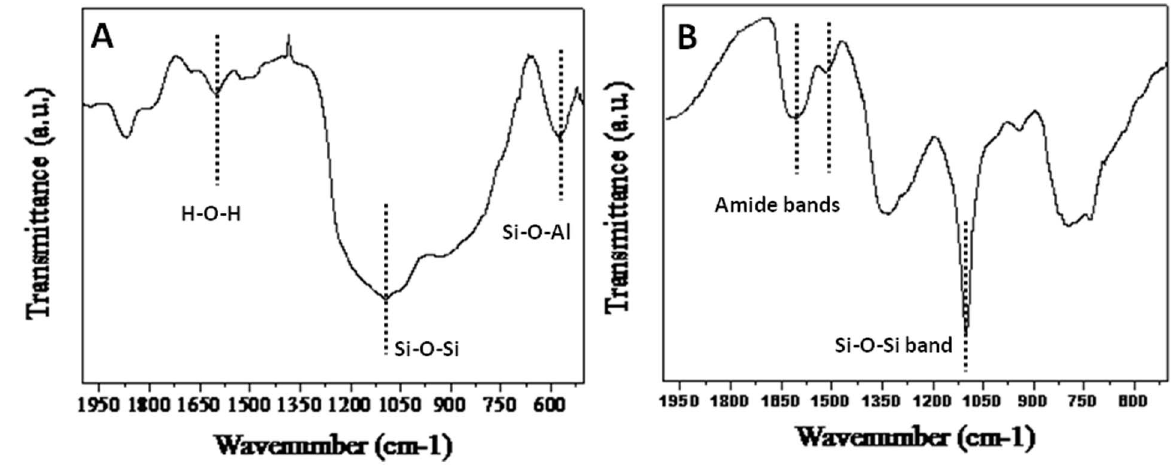
Figure 5. Fourier Transform Infrared (FTIR) spectrum of Fly-ash powder (A) and bioleached silica nanoparticles obtained after reacting Fly-ash with Fusariumoxysporum for 24 h